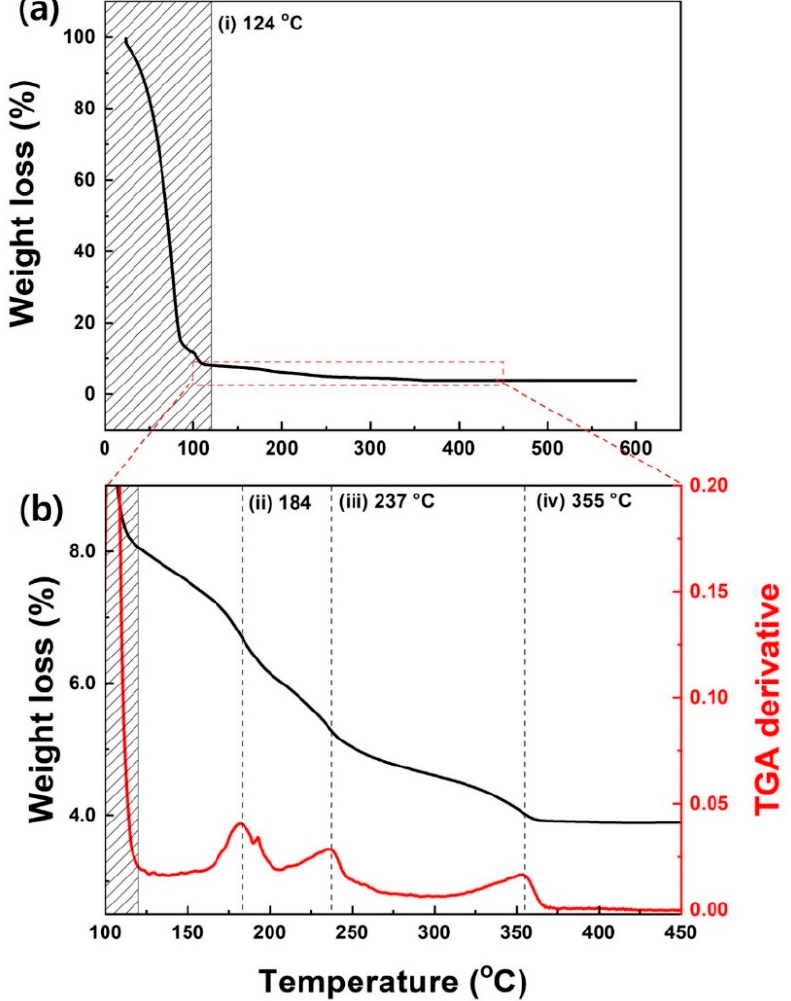
Figure 6. TGA result of IZO solution for a -IZO film fabrication. ( a ) Weight loss versus temperature graph, and ( b ) enlarged weight loss/differential TGA graph at 100–450 °C.